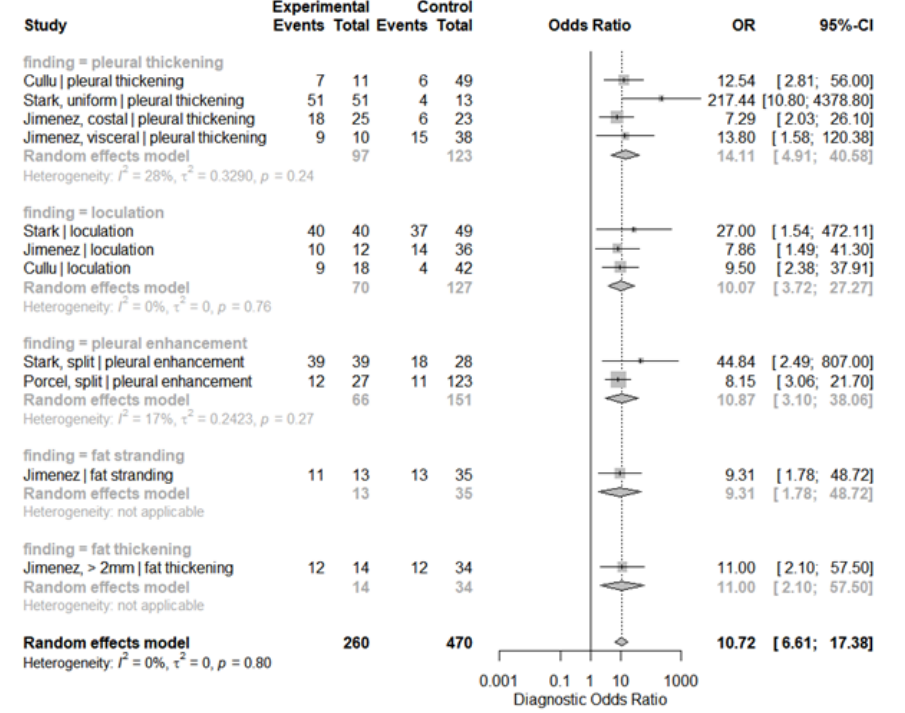
Figure A3: DOR of informative pleural findings to detect pleural empyema in parapneumonic effusions.